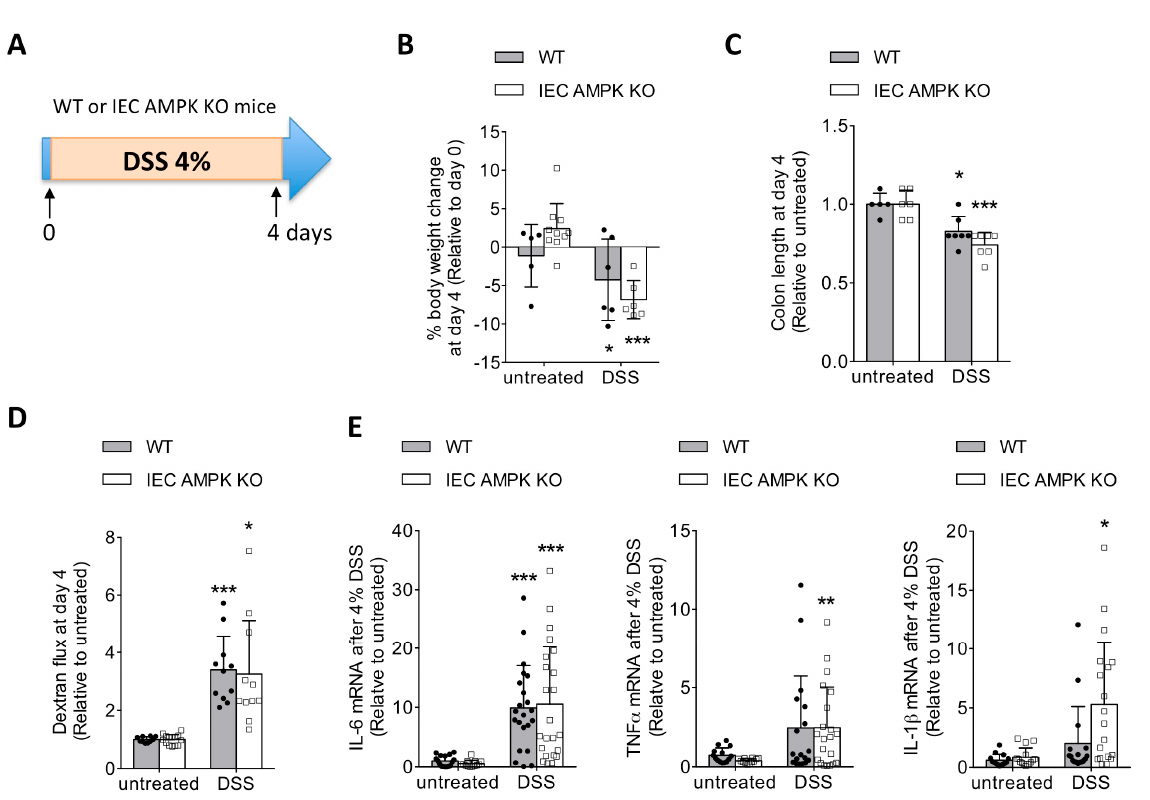
Figure 1. DSS-induced colonic injury and inflammation in WT and IEC AMPK KO mice. ( A ) Experimental timeline for 4% DSS-induced colitis in female WT and IEC AMPK KO mice. Mice were treated with 4% DSS in drinking water for four consecutive days. Changes in ( B ) body weight and ( C ) colon length in WT and IEC AMPK KO mice on day 4 of 4% DSS-induced colitis ( n = 5–10 mice/group). ( D ) In vivo paracellular intestinal epithelial permeability of WT and IEC AMPK KO mice on day 4 during 4% DSS-induced colitis protocol. Dextran flux was determined by measuring the amount of 4 kDa TRITC-dextran in the plasma 4 h after gavage ( n = 10–14 mice/group). ( E ) Expression of mRNA for Il-6, TNF- α and IL-1 β in the colon from WT and IEC AMPK KO mice on day 4 ( n = 16–23 mice/group). The results are pooled from four independent experiments. Data are expressed as means ± SD. Statistical analysis was performed by one-way ANOVA with the post hoc Bonferroni’s multiple comparisons test; * p < 0.05, ** p < 0.01 and *** p < 0.001 indicate a significant change relative to the untreated condition.